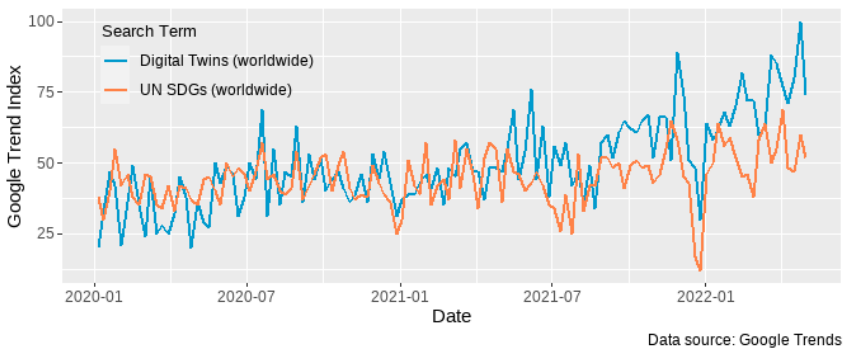
Figure 1. Worldwide Google Trends for UN SDGs and digital twins since